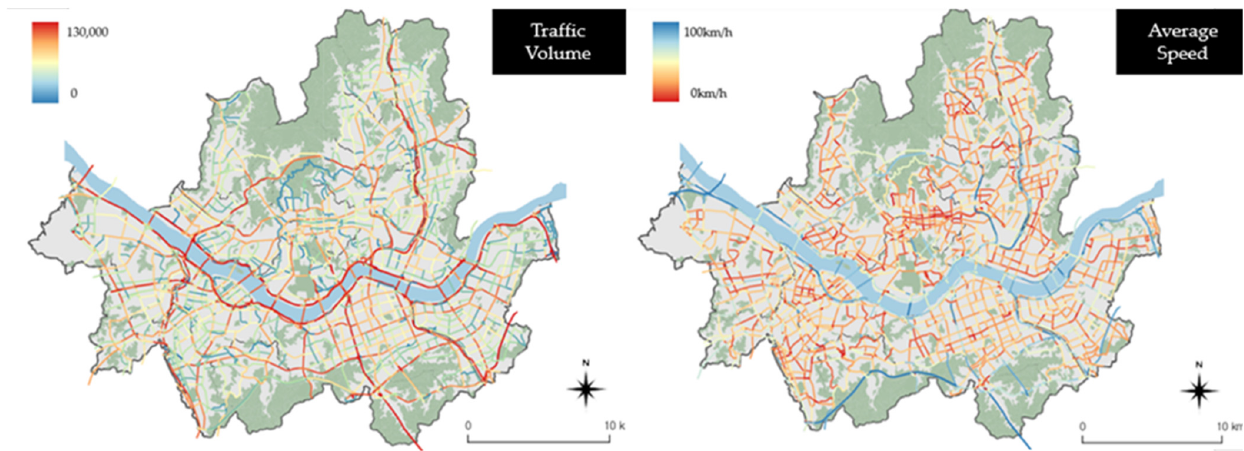
Figure 3. Seoul’s traffic volume (left) and average speed (right) by the link units.